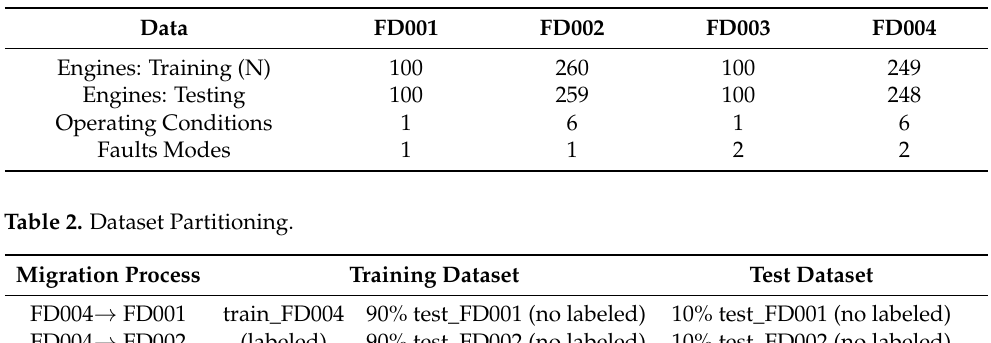
Table 1. C-MAPSS dataset.